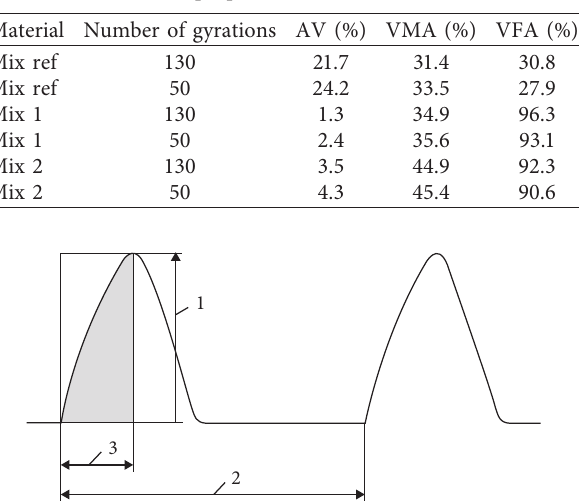
Figure 3: Load applied in the IT-CY test. (1) peak load; (2) pulse repetition load; (3) rise